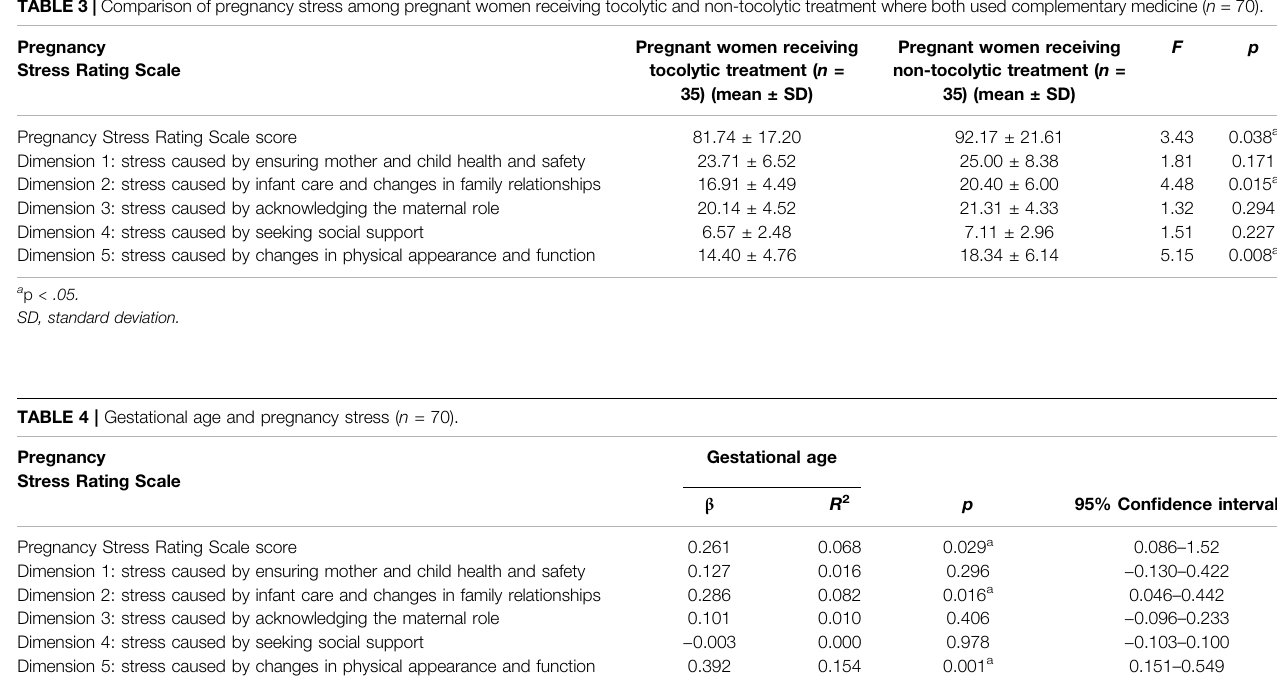
Dimension 2: stress caused by infant care and changes in family relationships Dimension 4: stress caused by seeking social support Dimension 5: stress caused by changes in physical appearance and